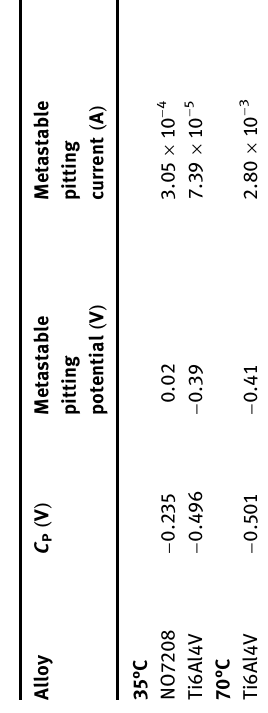
appearing due to passivation of the steel at potentials less than the pitting potential [ 63 ] . At 35°C, Ti6Al4V and NO7208 exhibited metastable pitting behavior. Meta - stable pitting on Ti6Al4V polarization plot occurred at potential and current of − 0.39 V and 7.39 × 10 − 5 A, respec - tively compared to NO7208 at 0.02 V and 3.05 × 10 − 4 A. This signi fi es that Ti6Al4V has a higher resistance to metastable pit formation compared to NO7208. This is further con fi rmed from the wider metastable pit region on the polarization plot of NO7208. Occurrence of meta - stable pitting on Ti6Al4V was gradual where there was a delayed transition. However, on NO7208, the transition was instantaneous over short potential range. Both alloys passivated at potentials of − 0.21 and 0.19 V, and current of 2.50 × 10 − 5 and 2.54 × 10 − 5 A. At a potential of 1.04 V, stable pitting activity is obvious on the anodic polariza - tion plot of NO7208, signifying breakdown of its protective oxide. However, this occurred almost instan - taneously due to short transpassive behavior on the polarization plot [ 64,65 ] . The passivation range shows the resilience of NO7208 passive fi lm before it collapses. In accordance with Machet et al. [ 66 ] , the protective oxide on NO7208 consists of a furthermost fi lm of Ni ( OH ) , a middle fi lm of Cr ( OH ) , and an interior fi lm of 2 3 Cr O oxide protecting the alloy. Passivation behavior 2 3 was totally missing on the polarization plot of NO7208 alloy at 70°C. Increase in temperature of the electrolyte signi fi cantly in fl uenced the stability of NO7208 passive fi lm especially within the acid - chloride environments due to the accelerated agitation and di ff usion of the reacting species [ 66 – 68 ] . According to Ahn et al. [ 69 ] , reaction of corrosive anions with the protective oxide of NO7208 increases cation vacancies which are respon - sible for the collapse of its oxide. Ti6Al4V did not exhibit stable pitting activity throughout because of the strength of its protective oxide. However, the plot in Figure 1a shows that the passive fi lm is marginally unstable. At 70°C, Ti6Al4V exhibited metastable pitting and passiva - tion behavior. Metastable pitting occurred at − 0.41 V and 2.80 × 10 − 3 A, while passivation due to the formation of stable TiO occurred at − 0.13 V and 1.62 × 10 − 4 A. The 2 anodic polarization plot in Figure 1a and b, and the poten - tiostatic data show that Ti6Al4V does not pit, i.e., it undergoes localized corrosion degradation or stable . pitting activity despite having the highest general C R TiO remained resilient or in the active phase through 2 formation of complex precipitates during potential scanning [ 70 ] . T a